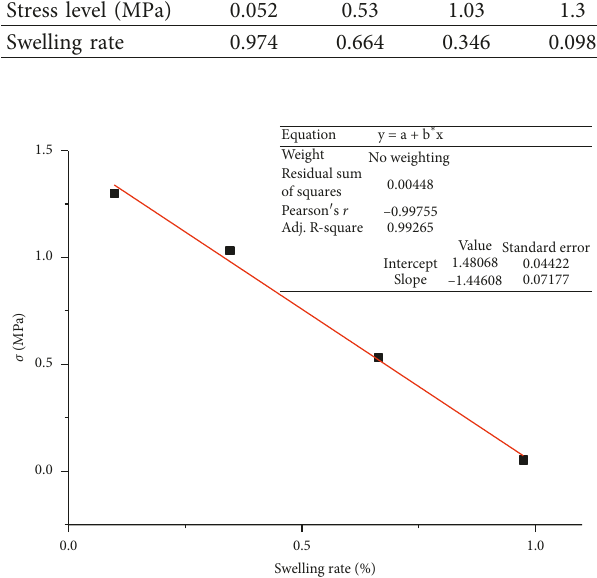
Figure 7: Relationship of axial stress and swelling deformation